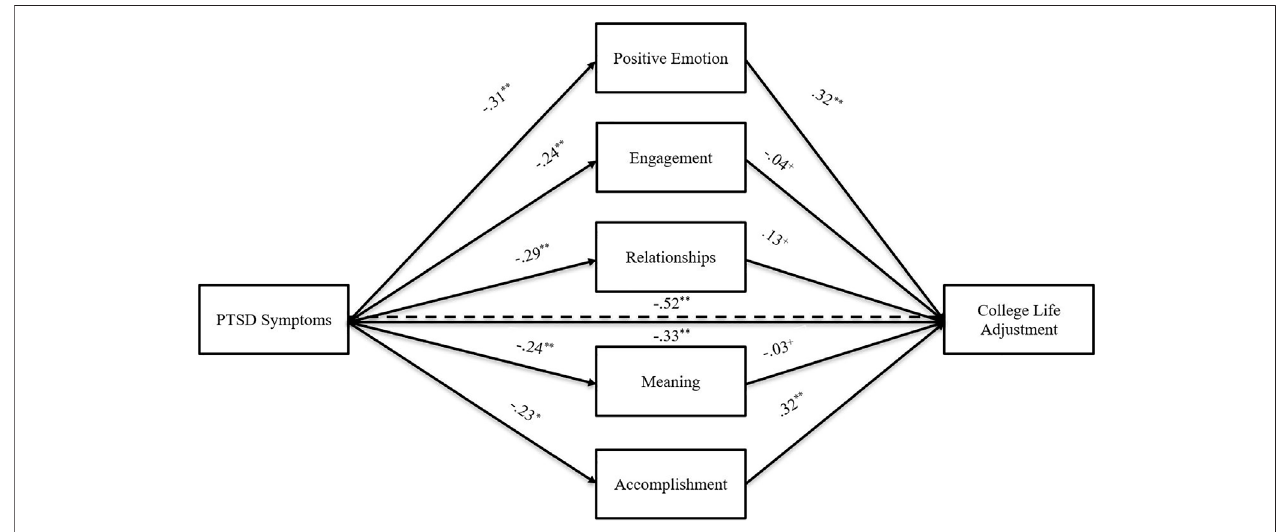
FIGURE1 | Multiple MediationModel Examainingthe Relationship Between PTSD Symptomsand College LifeAdjustment. Note. Dottedline denotes the effect of PTSD Symptoms on college life adjustment when mediaters are not included * p < 0.01, ** p < 0.001, − p (cid:1) n.s.